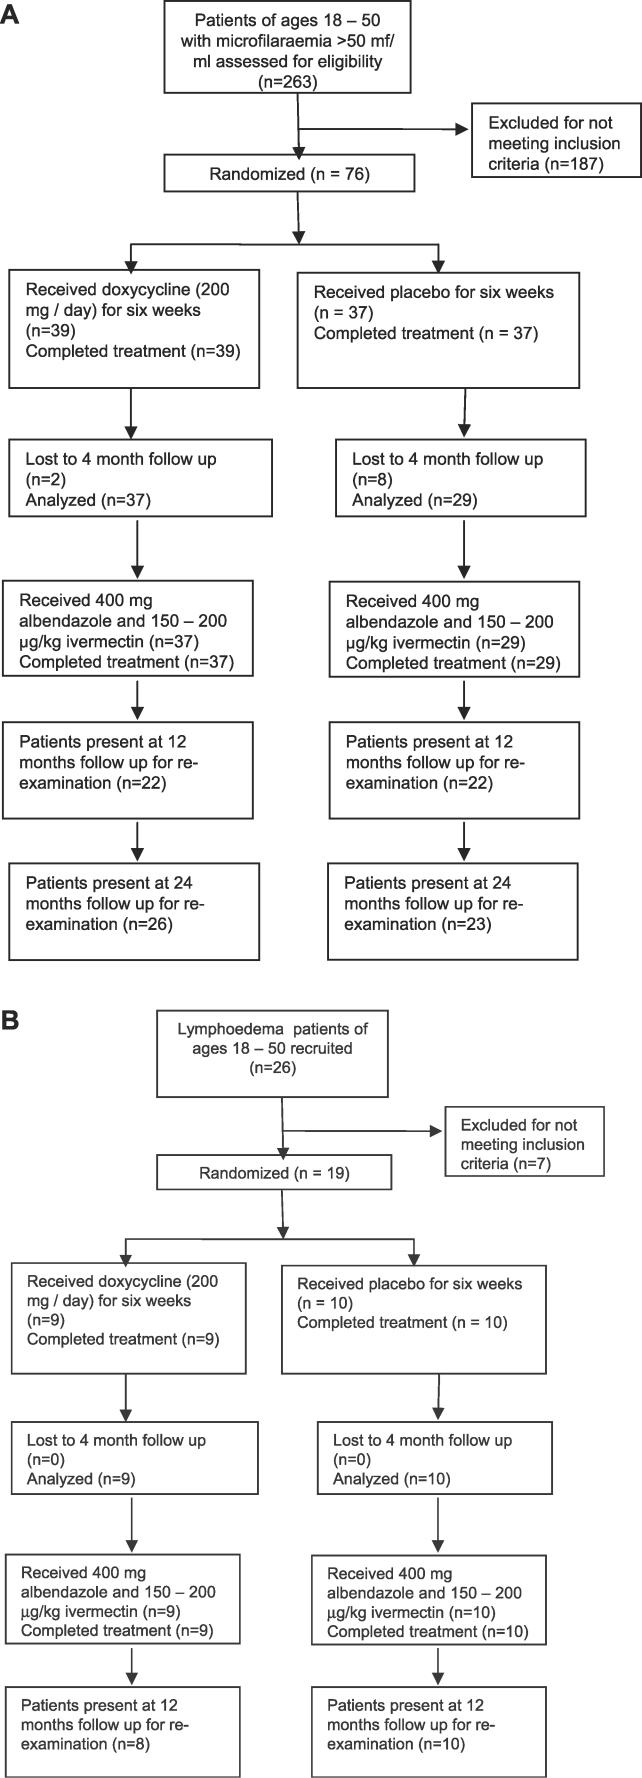
Flowchart of Patient Participation(A) Trial profile of microfilaremic patients. Of the 76 patients, 33 (17 doxycycline and 16 placebo) patients were present at all time points.(B) Trial profile of lymphedema patients. Of the 19 patients, 18 (eight doxycycline and ten placebo) patients were present at all time points.